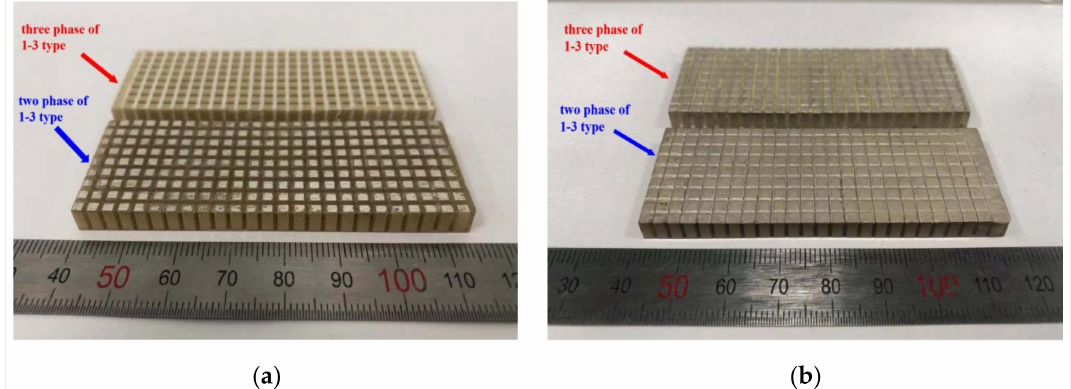
Figure 8. 1–3 piezoelectric composite and its array structure. ( a ) Two samples of 1–3 piezoelectric composite materials; ( b ) 1–3 piezoelectric composite array after electrode preparation by mask.